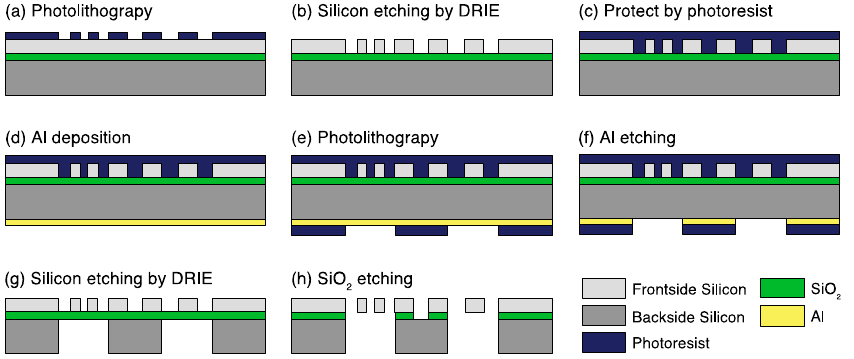
Figure 5. Fabrication process of the device. ( a ) Frontside photolithography, ( b ) Frontside silicon etching, ( c ) Protecting frontside structures, ( d ) Backside Al deposition, ( e ) Backside photolithography, ( f ) Al etching, ( g ) Backside silicon etching, ( h ) SiO 2 removal.